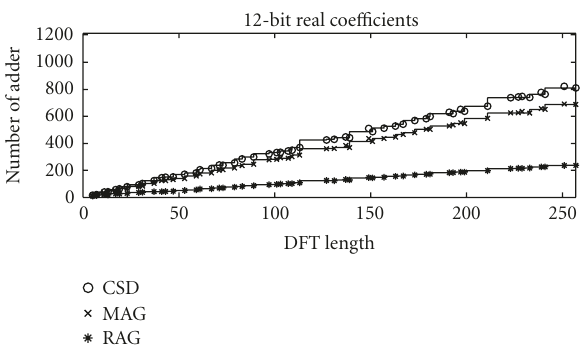
Figure 3: E ff ort for a complex multiplier block design in the Rader algorithm.